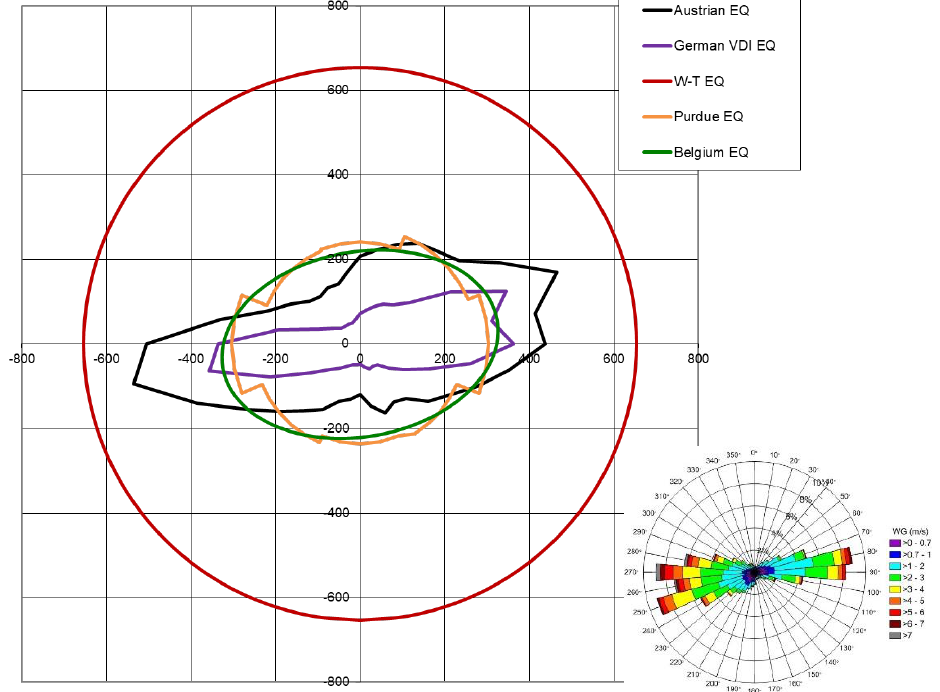
Figure 1. Separation distances calculated using the German VDI [5,14], Austrian [15], Belgian [16], Purdue [19] and Williams and Thompson (W-T) [21] empirical equations (EQs) for a protection level of rural areas and a 3000 head fattening pig livestock building. The wind statistics (frequency of wind directions and wind velocity per 10° sectors) from a site in Wels, Austria, are shown separately.